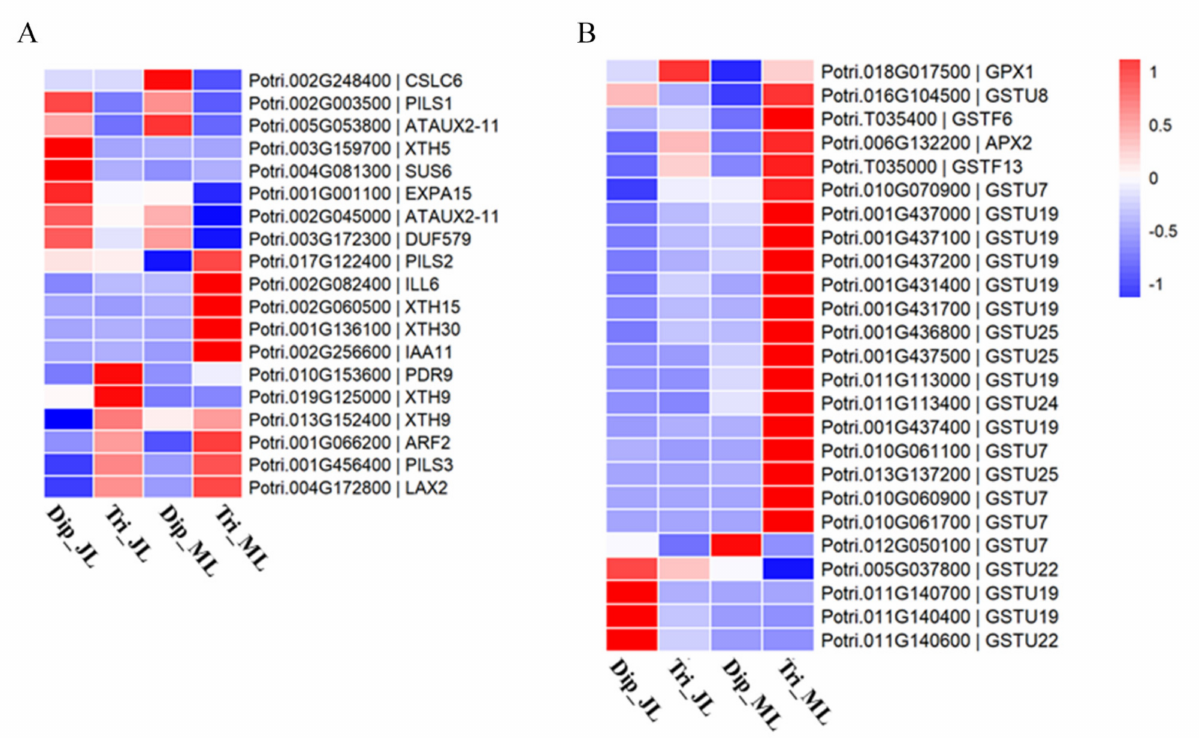
Figure 5. Expression profiles of DEGs. ( A ) DEGs related to cell growth. ( B ) DEGs related to antioxidant enzymes. The color scale represents the log − transformed RPKM value. Dip_JL, juvenile diploid leaves; Dip_ML, mature diploid leaves; Tri_JL, juvenile triploid leaves; Tri_ML, mature triploid